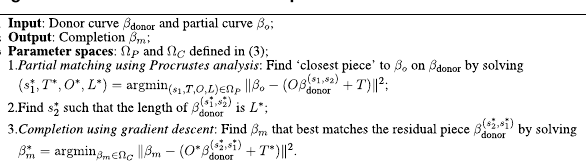
Algorithm 2 outlines our adapted hot-deck